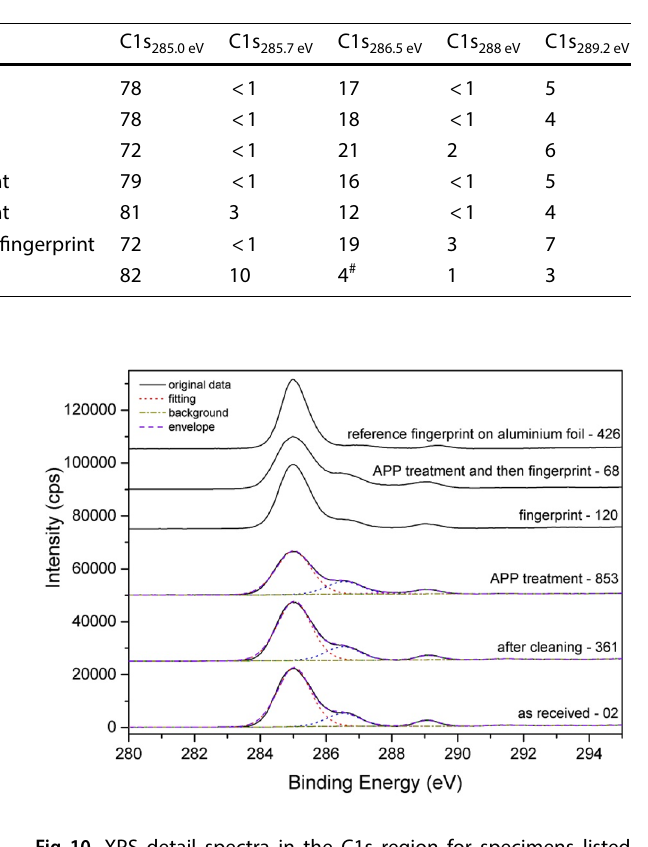
Table 2 XPS findings indicating the atomic composition (in at%) for green ABS-PMMA substrates that had undergone distinct intentional surface contamination and pre-treatment (# contributions from aluminium foil which shows a surface concentration ratio [O]/[Al] = 1.2)